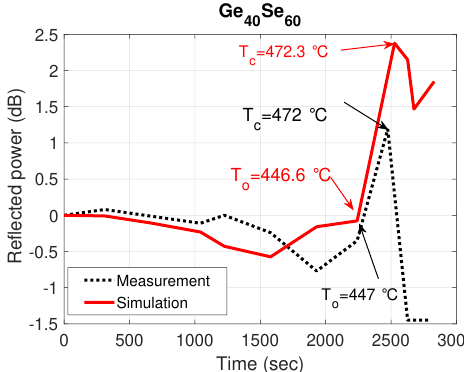
Figure 5. Simulated and measured normalized reflected power as a function of time with Ge 40 Se 60 - capped fiber